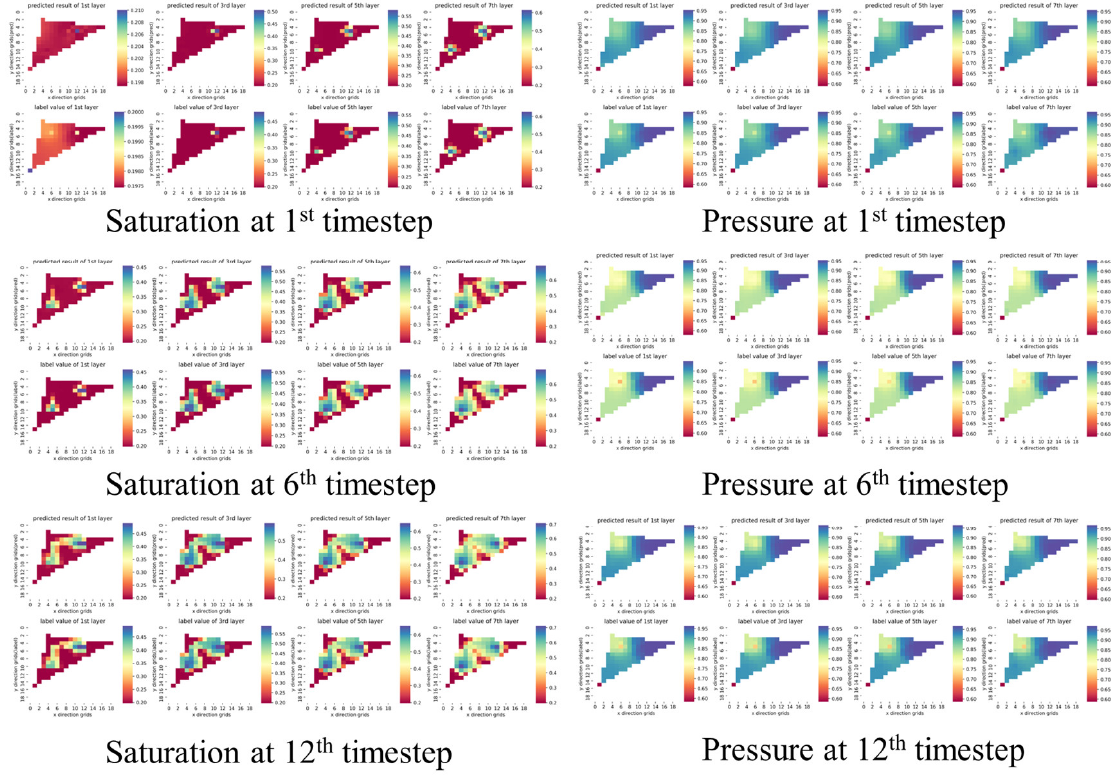
Figure 16. The comparison of two fields by our method (predicted) and simulator (labels) for trian- gle-shaped reservoir Case 1.